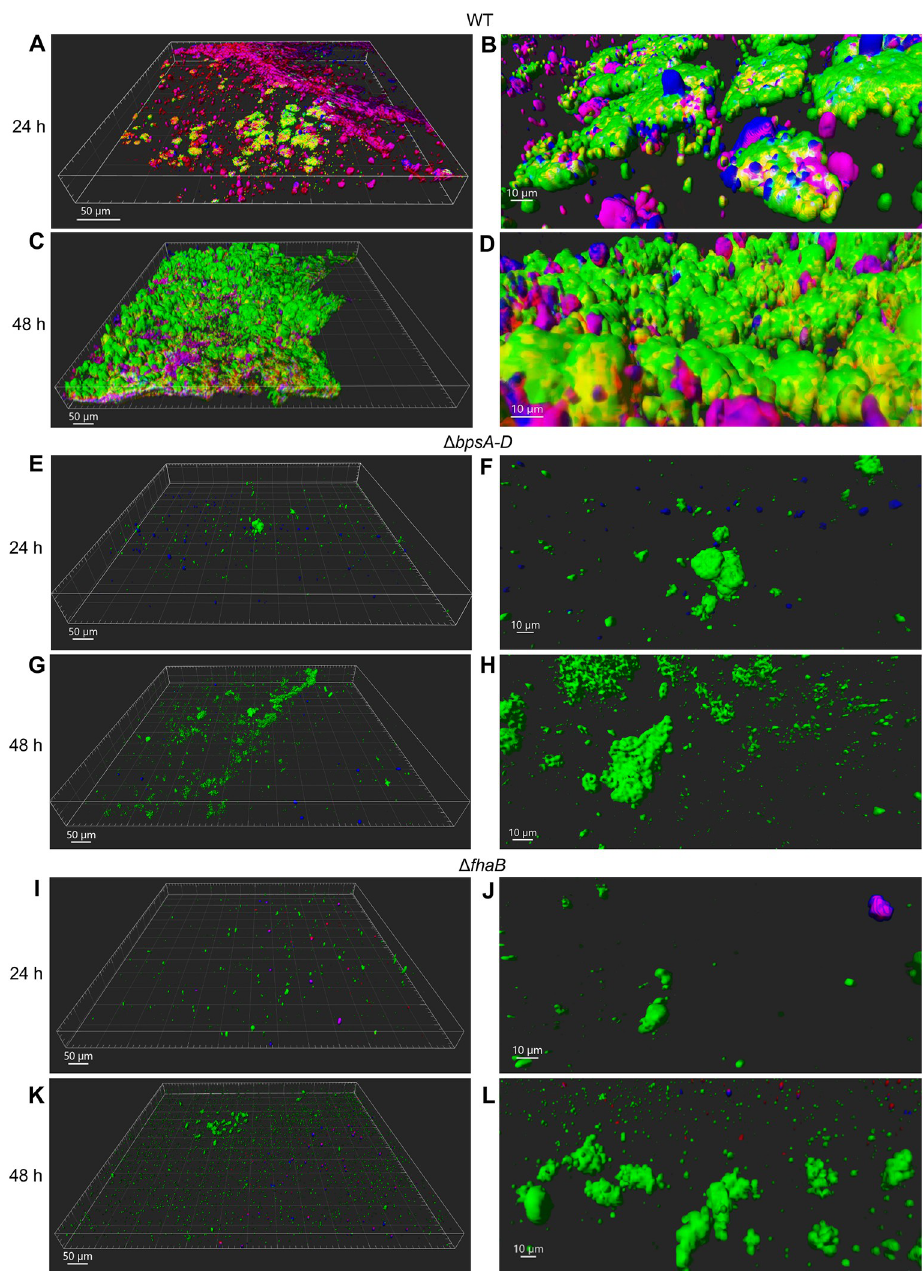
Fig 4. Visualization of Bp biofilms and ECM components on HBE cells. HBE cells infected with GFP-expressing WT (A-D), Δ bpsA-D (E-H), or Δ fhaB (I-L) strains for 24 h (A-B, E-F, I-J) or 48 h (C-D, G-H, K-L) were fixed and stained for Bps ( α -PNAG, red) and eDNA ( α -dsDNA, blue), then imaged using an Olympus FV3000 confocal microscope (20X objective). B, D, F, H, J, and L are zoomed in images of A, C, E, G, I, and K, respectively. Z-stacks were acquired at 1- μ m intervals. IMARIS software was used to produce a shading picture of the biofilms. this phenotype by comparing biofilm formation on polystyrene microtiter plates between the WT and Δ cyaA (containing an in-frame deletion in cyaA gene, encoding ACT [33]) strains (Fig 5A). To examine if ACT plays a role in biofilm formation on human airway epithelium,